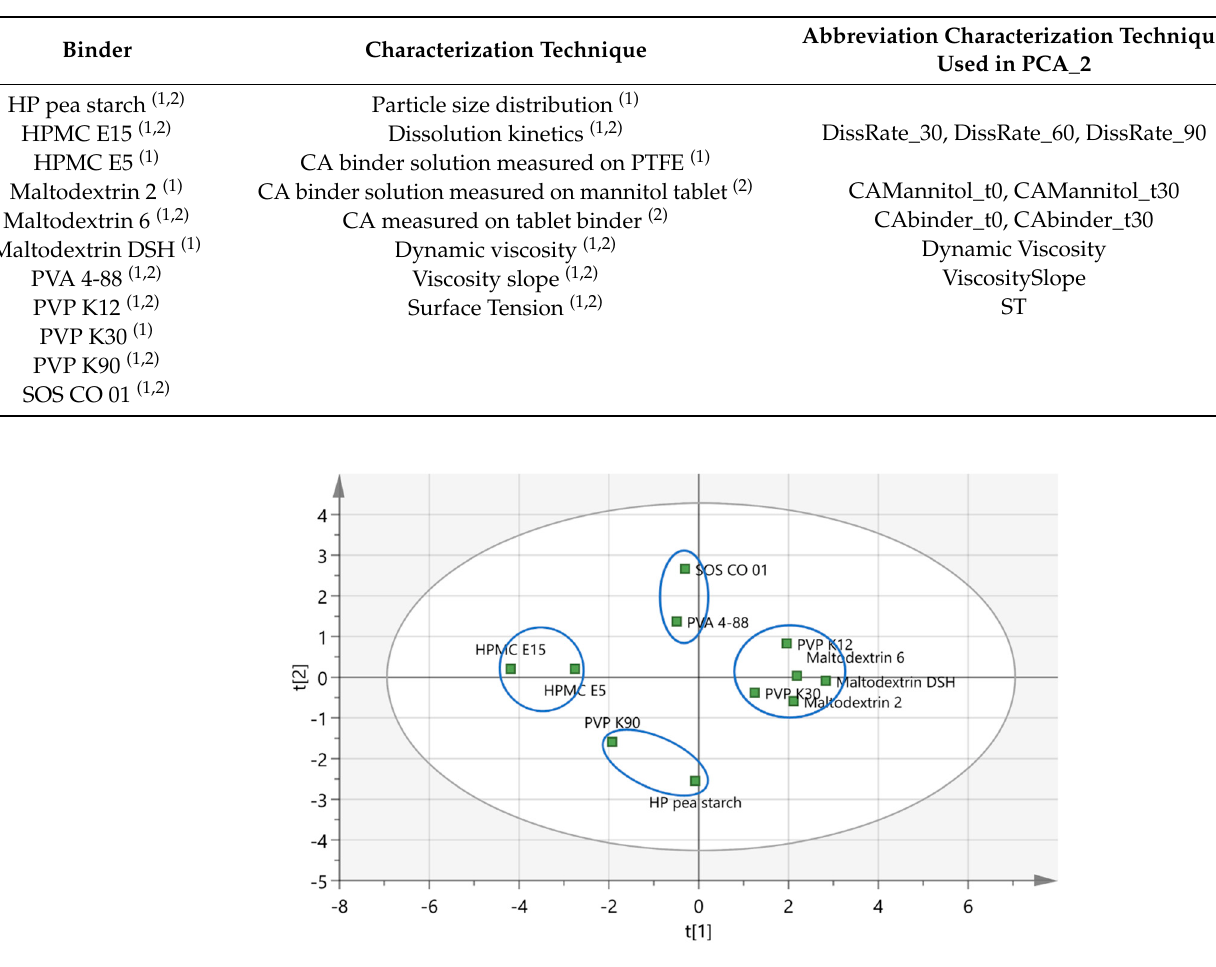
Figure 2. Score scatter plot illustrating principal component (PC) 1 versus PC 2 of PCA_1. Binder clusters are encircled [16].